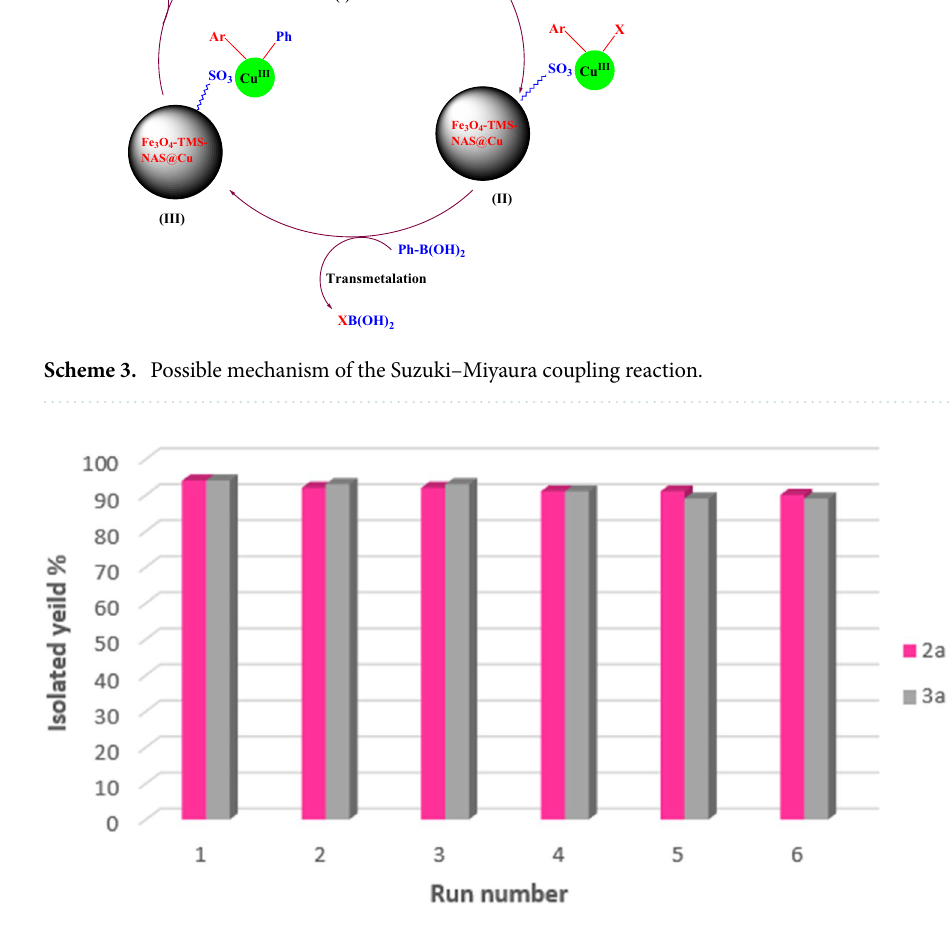
Figure 10. Recyclability of Fe 3 O 4 -PTMS-NAS@Cu MNPs in the synthesis of compounds ( 2a ) and ( 3a